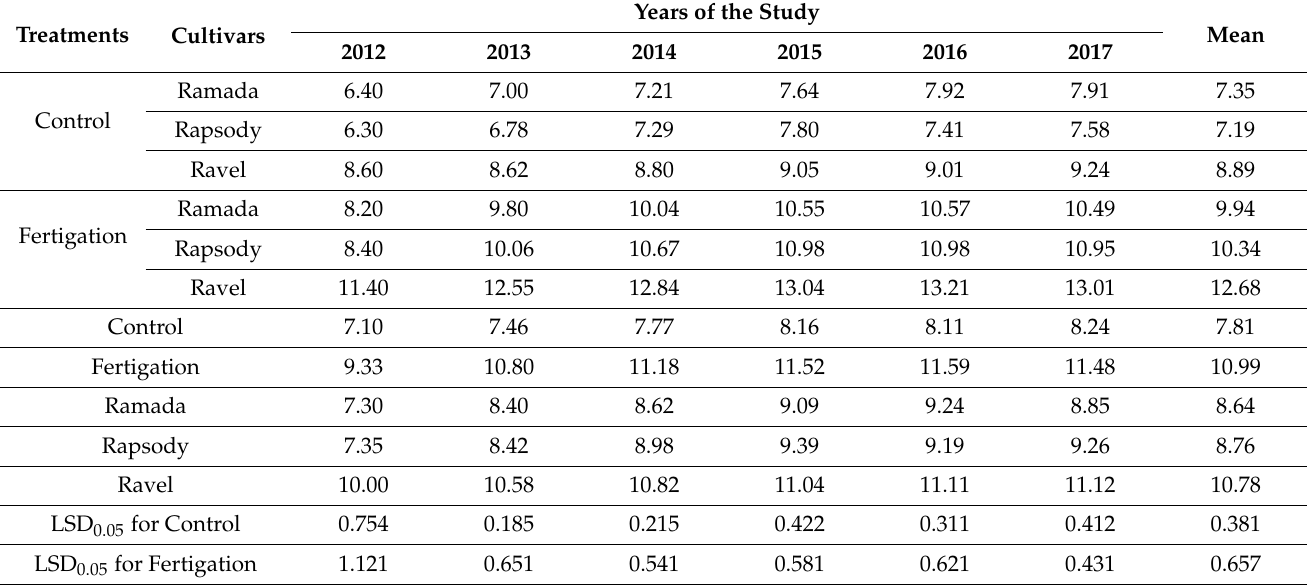
Table 6. The average number of spears (pcs per plant) harvested from one asparagus plant.